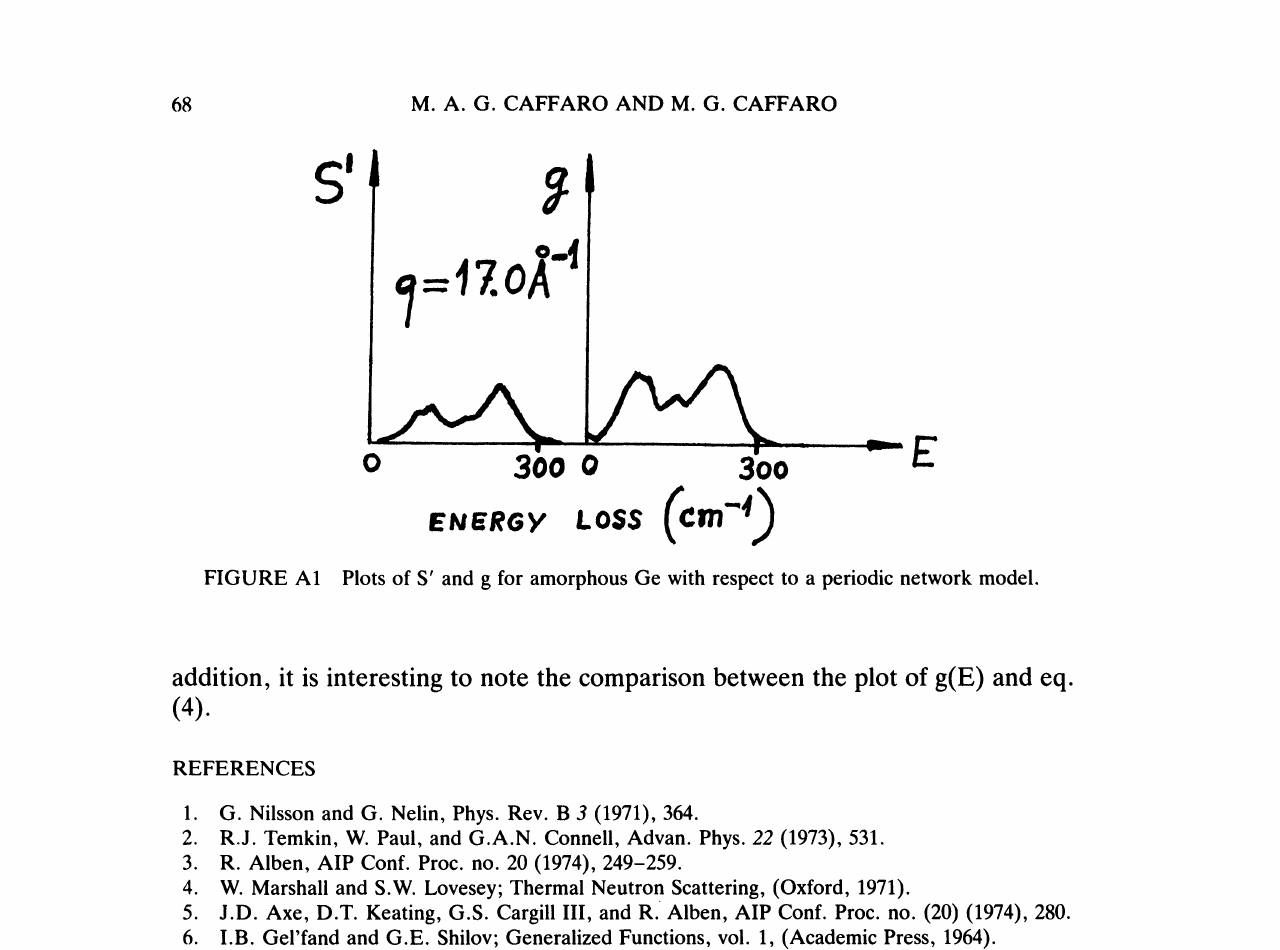
addition, it is interesting to note the comparison between the plot of g(E) and